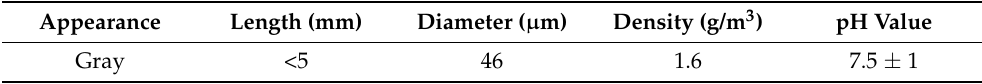
Table 4. Properties of lignin fiber.